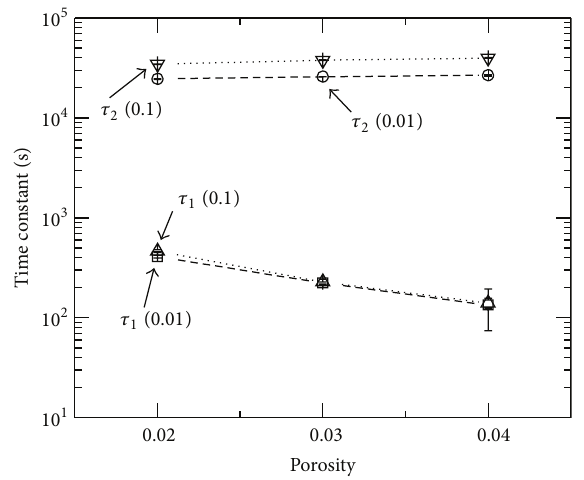
Figure 12: Time constants 𝜏 1 and 𝜏 2 as functions of porosity with the weighting parameter 𝜔 for the current density at the metal-coating interface as a parameter. The bulk conditions were 0.01M NaCl, pH 9, 10 −15 M Al 3+ and the coating was 0.1 mm